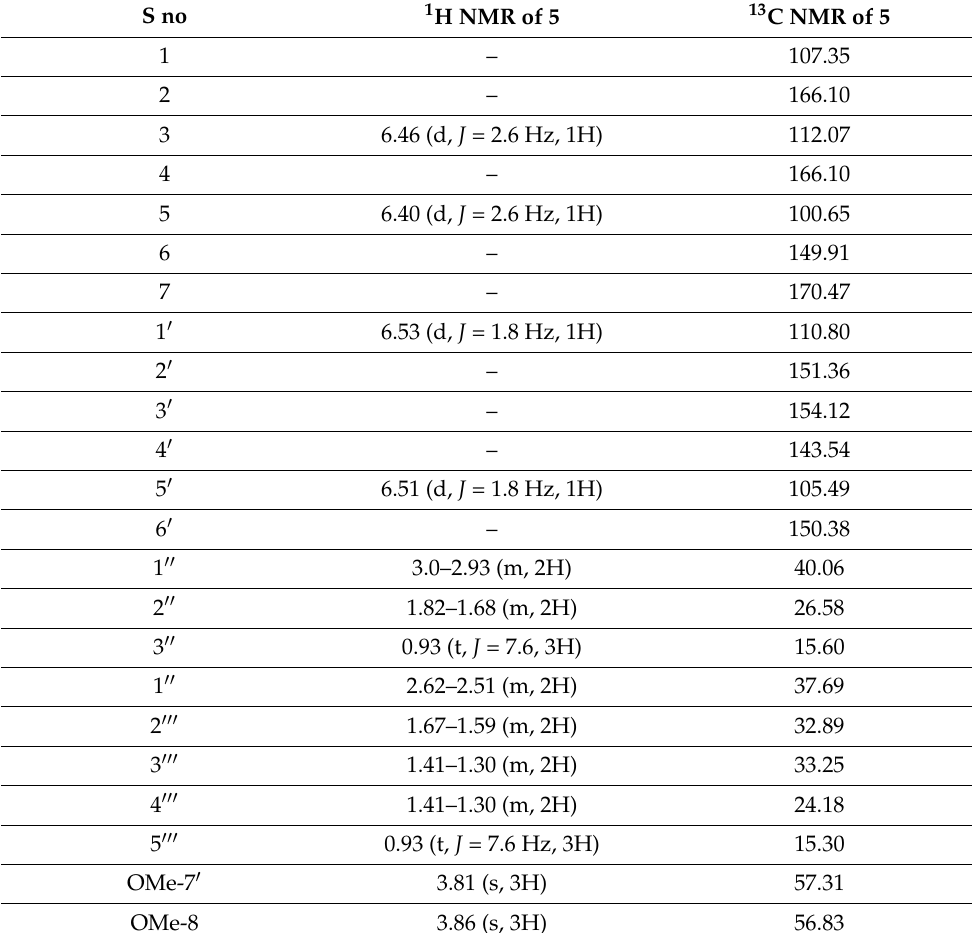
Table 1. NMR data of compound 5 (400 & 100 MHz, acetone- d 6 )